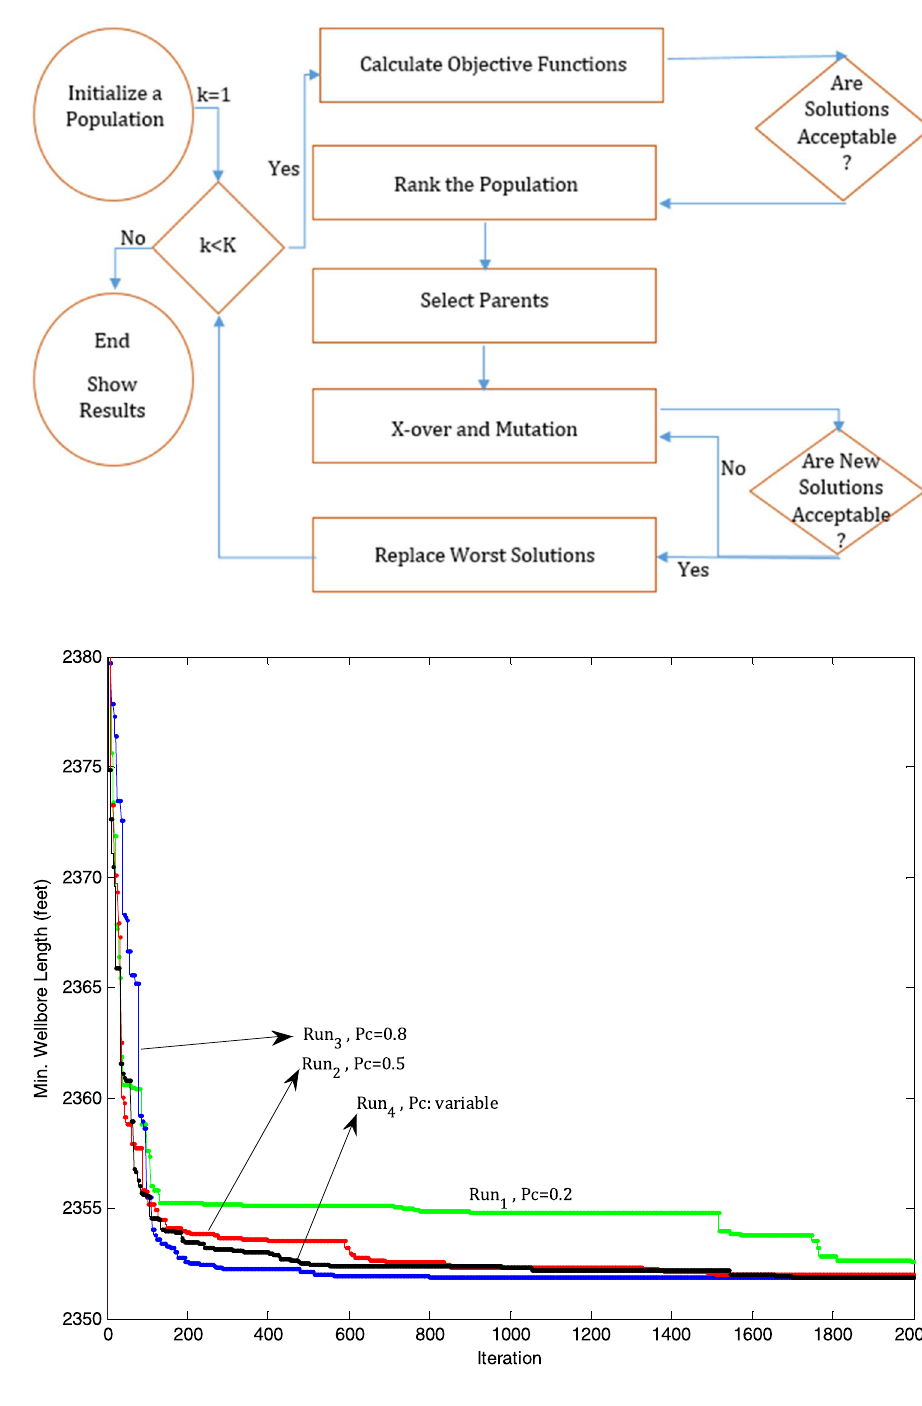
Fig. 6 Objective function trends compared for variable GA behavioral parameters versus constant-value GA behavioral parameters. The four runs (Case 1) illustrated were all conducted using the same initial popula- tion, i.e., the trends all begin with the optimum for an initial random sample population at the left side of the graph. Run 4 (i.e., variable behavioral param- eters) shows better performance than other runs (i.e., constant behavioral parameters). The better performance of Run 4 is characterized by it exiting local minima more rapidly than the other runs. Note that the mutation probability in the GA is obtained by the relationship P m = 1 − P